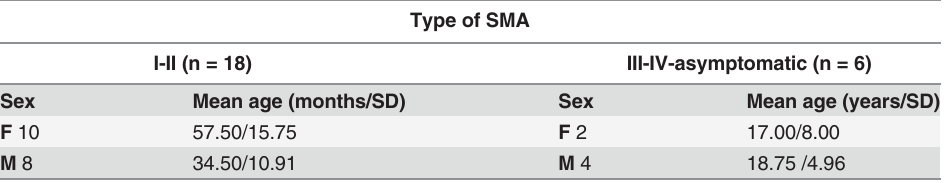
Table 2. SMA patients included in gene expression